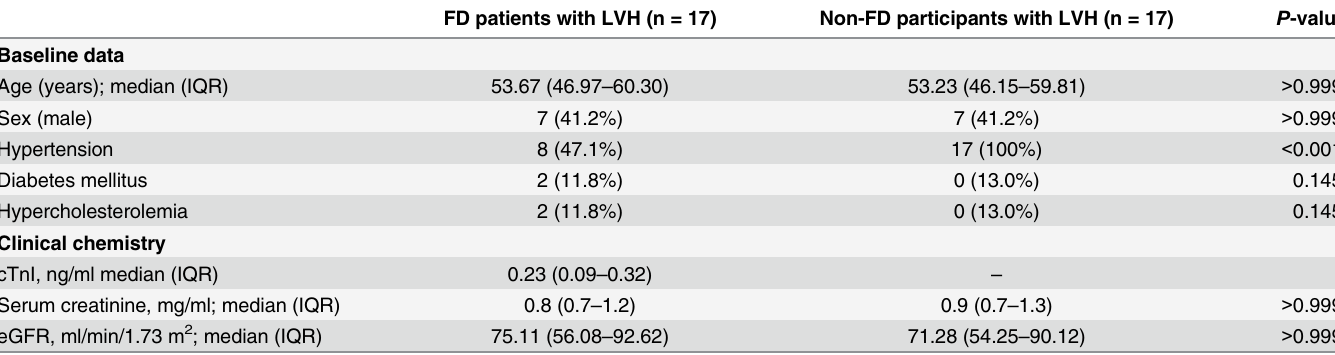
Table 4. Characteristics in 17 age- and sex-matched individuals with left ventricular hypertrophy due to